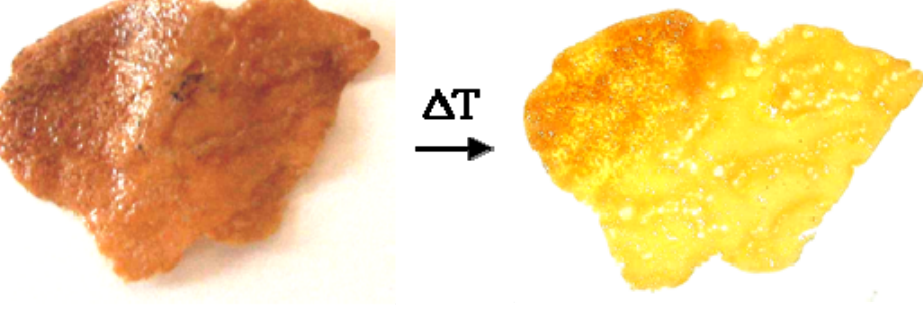
Figure 6. Characteristic reversible thermochromism of a film based on dodecyl-thiolate capped silver nanoparticles embedded into amorphous polystyrene (the material has been thermally cycled for ca. 30